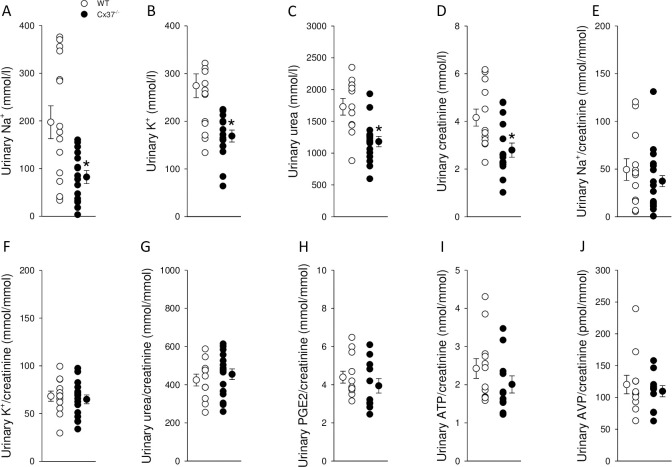
Urinary concentrations of Na+, K+, urea and creatinine were reduced in Cx37-/- compared to WT mice.Urinary concentrations of (A) Na+, (B) K+, (C) urea and (D) creatinine were reduced to ~42%, ~62%, ~68% and ~67% in Cx37-/- compared to WT, respectively. Corrected by urinary creatinine no significant differences were observed for (E) Na+, (F) K+, (G) urea, PGE2 (H), ATP (I) or AVP (J). Data are expressed as mean ± SEM; n = 12–17. Data were analyzed by Student’s t-test, *P<0.05 versus WT.